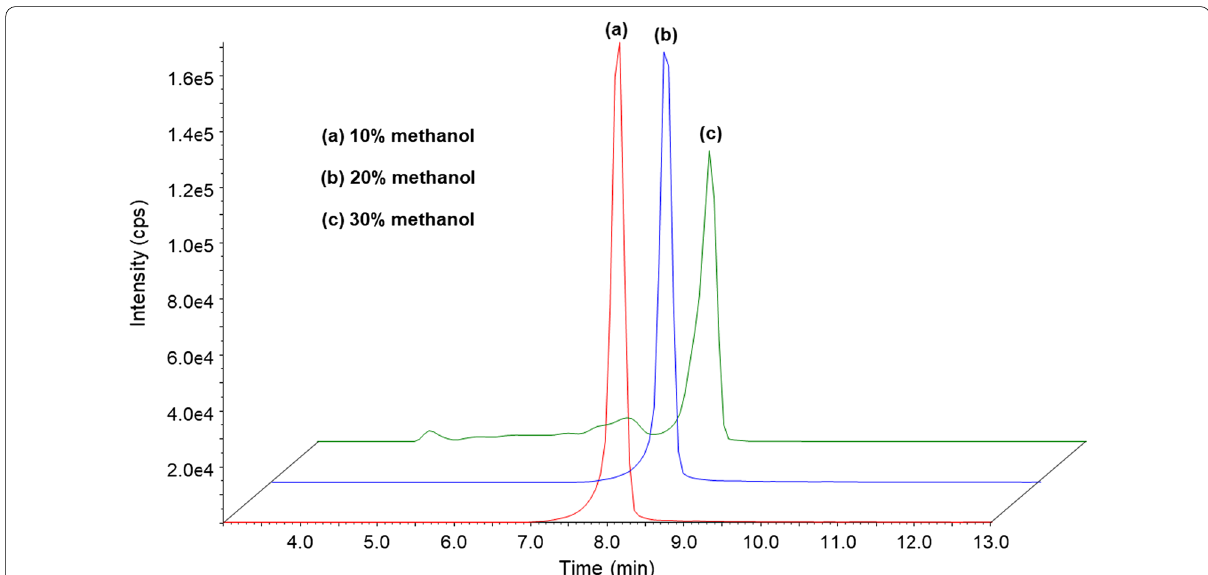
Fig. 1 Chromatograms of NTX at varying reconstituted solvent ratios used in the precipitation method a 10% methanol, b 30% methanol, and c 50%